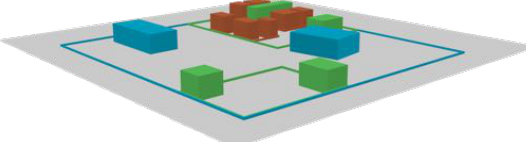
Figure 13: An alternative way to handle feature loading. Level two tiles (in orange) are loaded despite being far from the camera because they have been found to bring more information to the